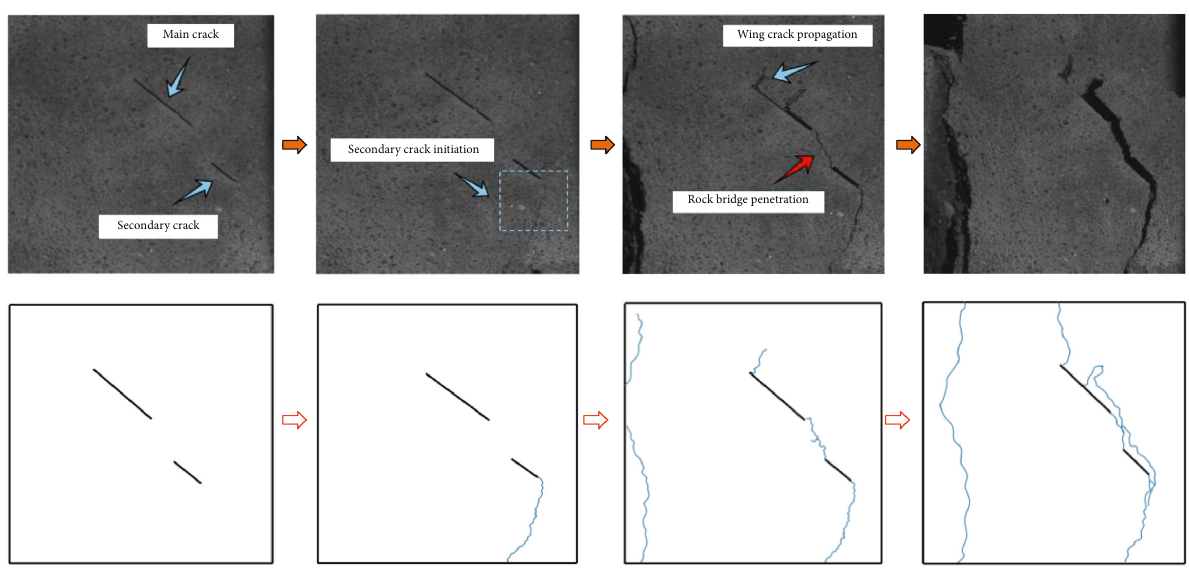
Figure 17: Crack propagation process of Specimen